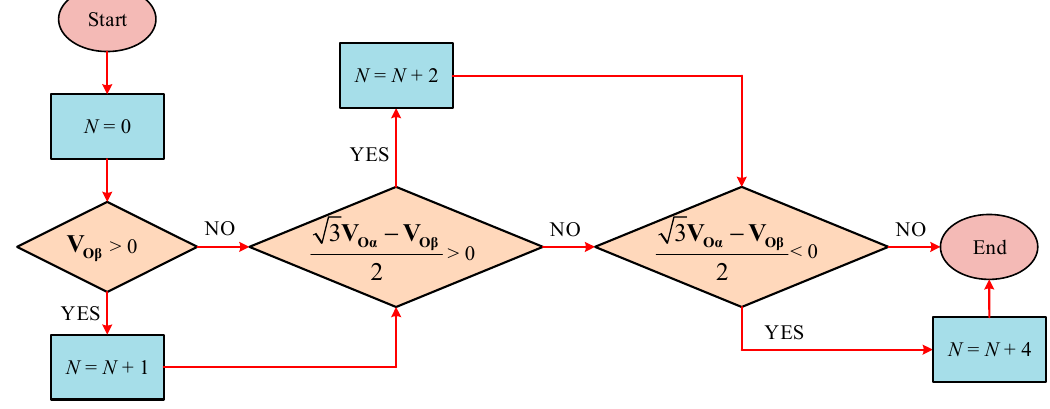
Figure 5. Sector indicator calculation algorithm.